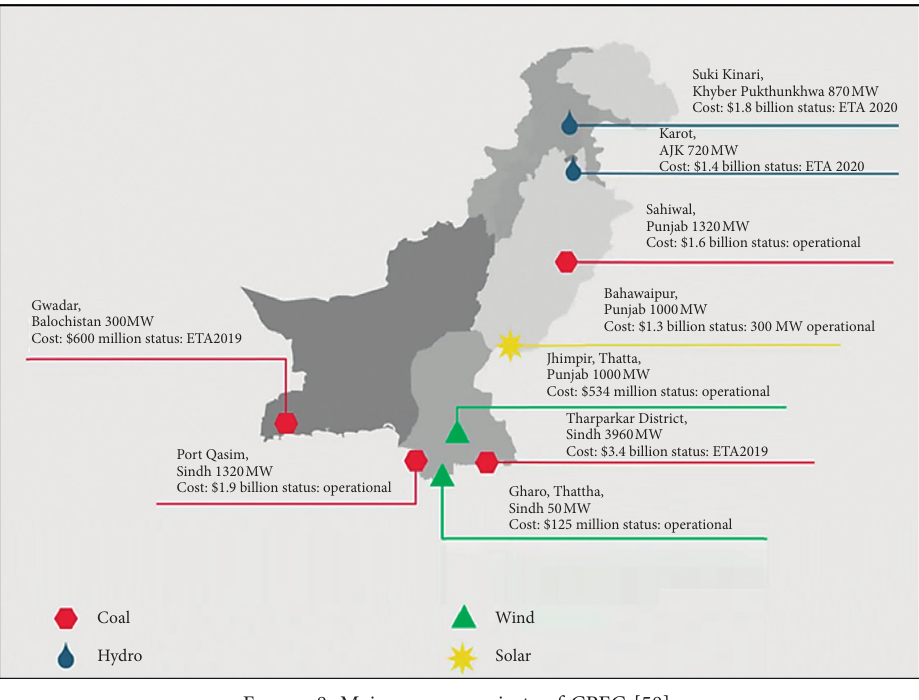
Figure 8: Major power projects of CPEC [58].